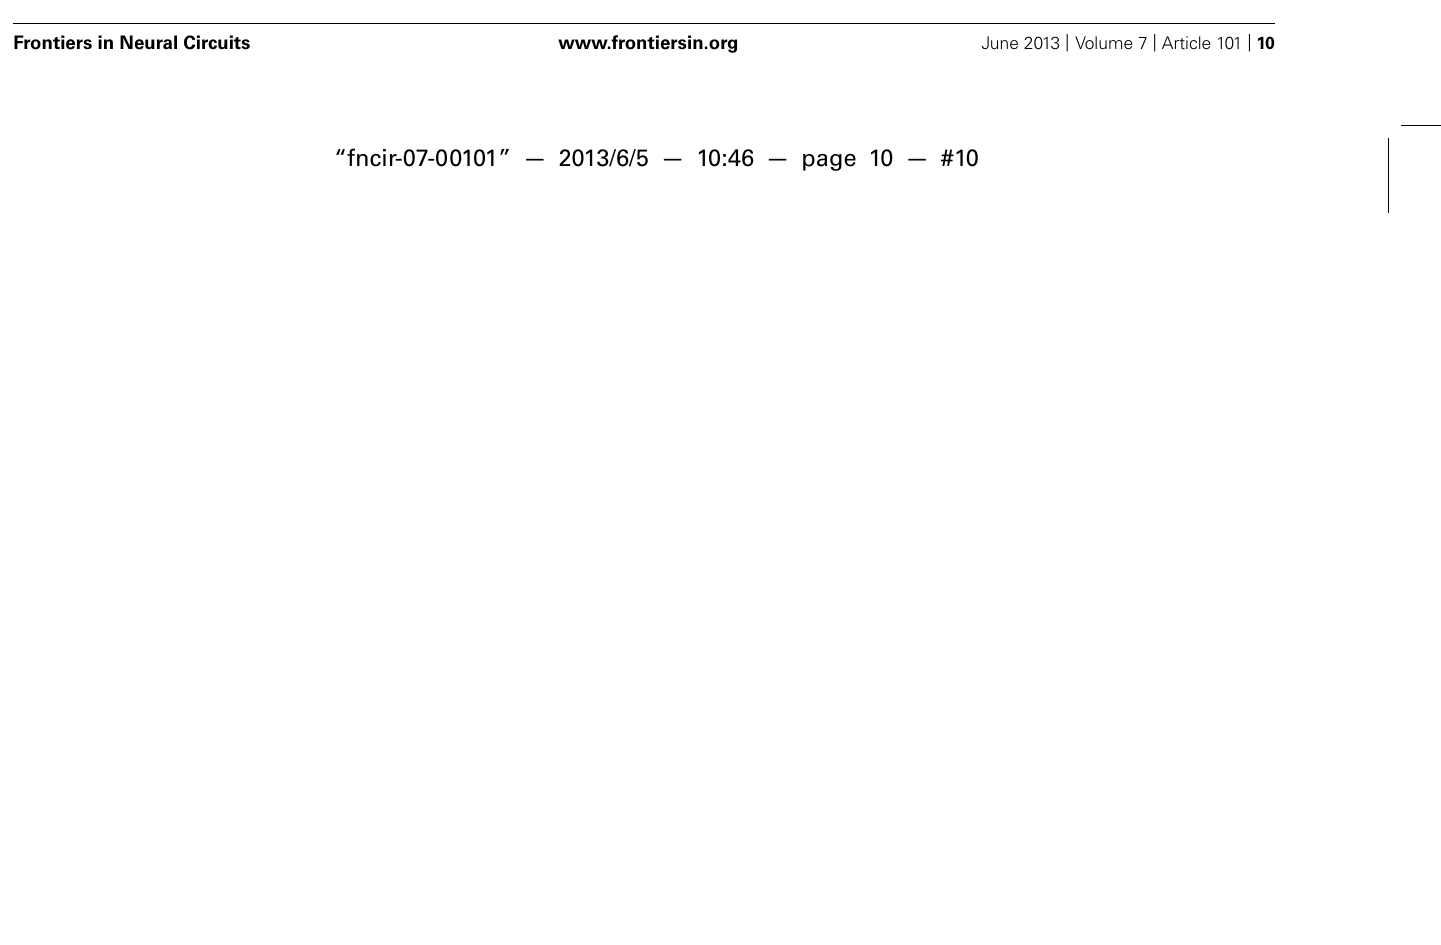
which may be well approximated by an exponential function (red dashed line).This is due to inhibition from the I-unit, as can be seen by setting v I = 0 (crosses). By contrast, optimally designed stimuli (blue dots) drive the gain function over its full range. (D) Estimates attained from training with random stimuli (green dots) exhibit continuous parameter confounding between the output weight and bias, as predicted by the exponential theory (black curve). In contrast, estimates attained from optimally designed stimuli accurately recover the true parameters (red